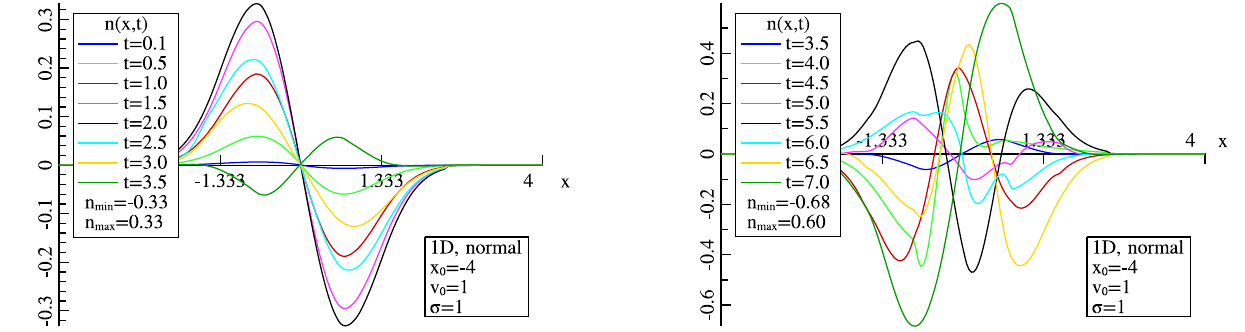
FIG. 6. Dynamics of the density n ð ~ x ; t Þ for the 1D plasma with the normal spatial and velocity distributions and for a charge starting moving from x 0 ¼ − 4 .